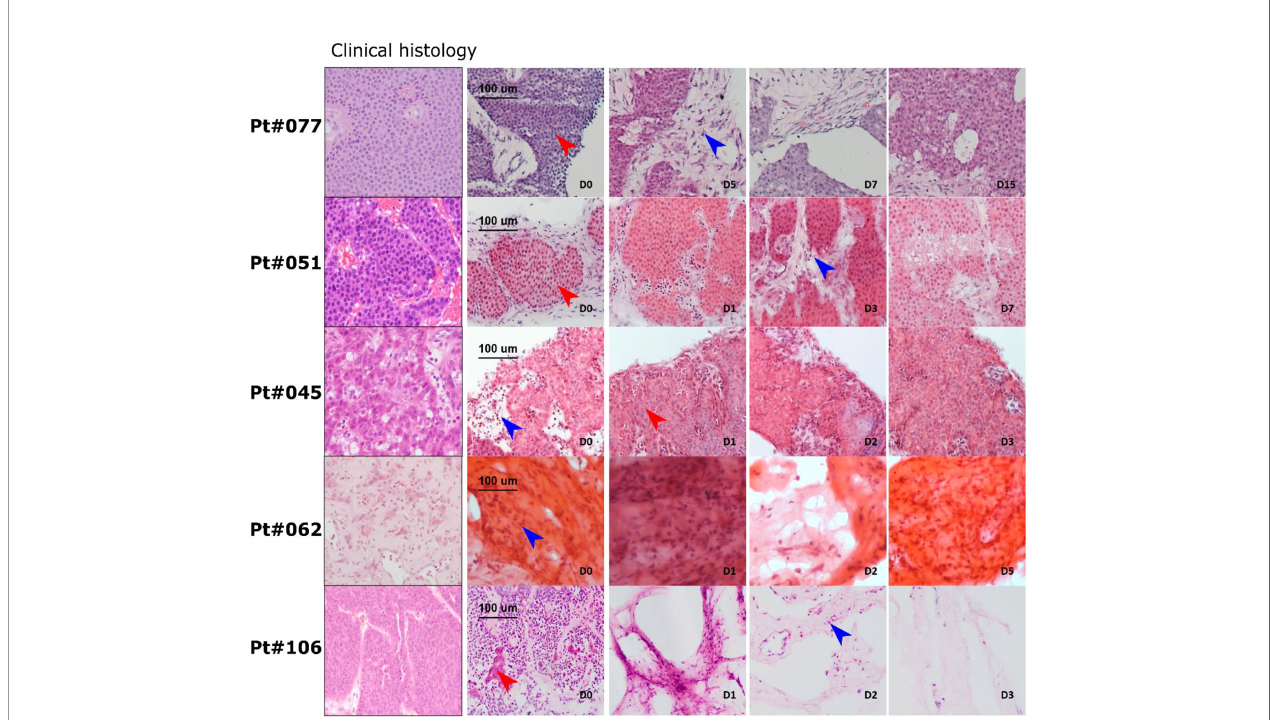
FIGURE 3 | LM-NEN PCTS retain patient speci fi c histoarchitecture in culture. Representative H&E images of tissue slices generated from 5 patients; 3 slices (D0- D7) or 1 slice (D15) were analysed per patient at each indicated timepoint. Tumour epithelium is indicated by red arrows and tumour stroma by blue arrows. Histoarchitecture was compared with clinical histopathology staining (left column) for each